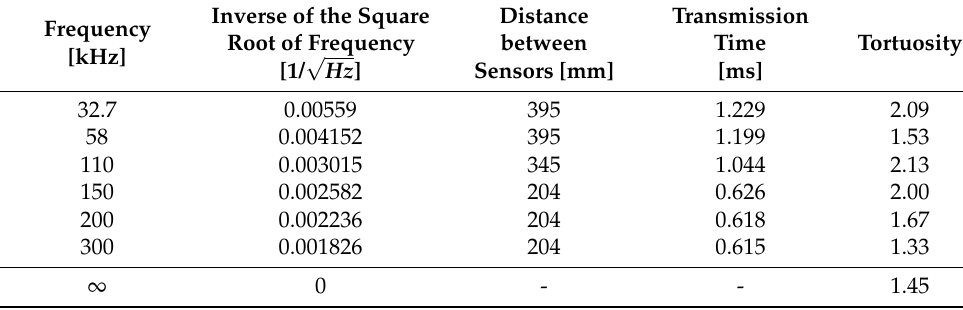
Table 1. Result of the tortuosity